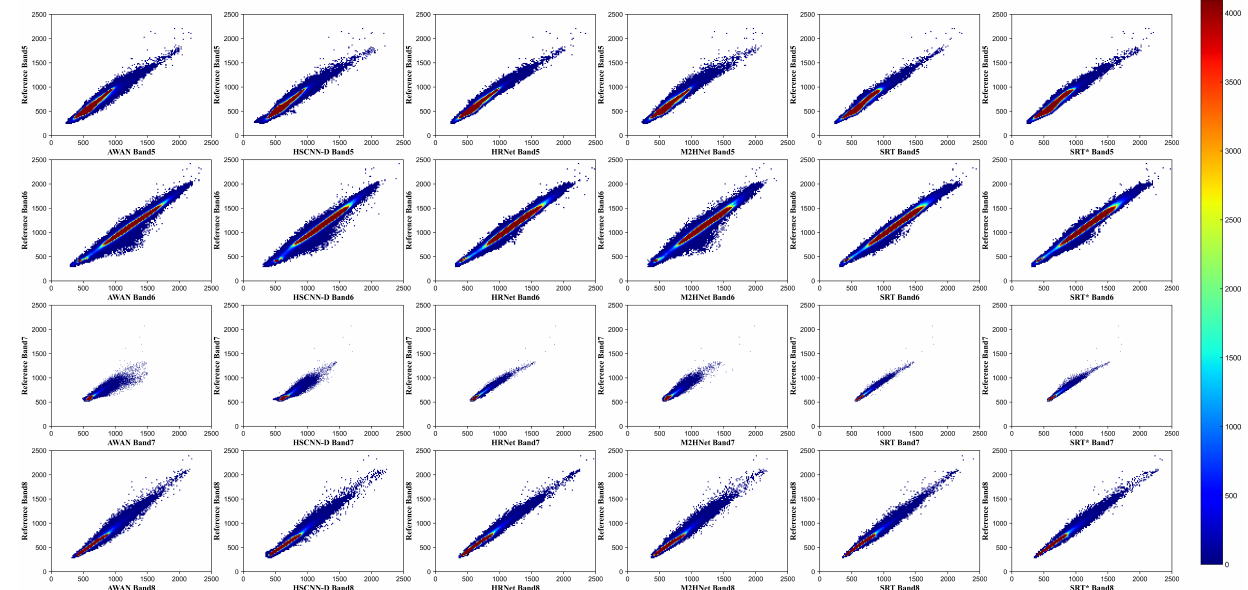
Figure 7. The scatter plot shows the predicted bands of each method compared with the origi- nal bands.